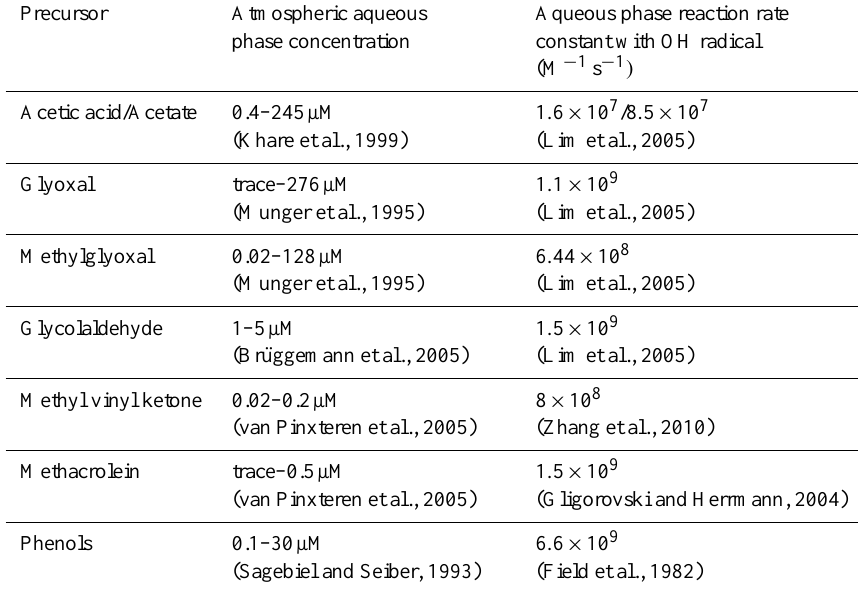
Table 1. Comparison of acetic acid/acetate with previously identified aqueous SOA